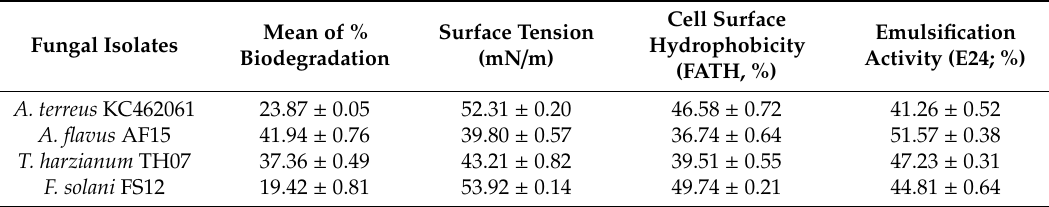
Table 3. Mean biodegradation percentage for four isolates, surface tension, cell surface hydrophobicity, emulsification activity after two weeks of incubation at 30 ◦